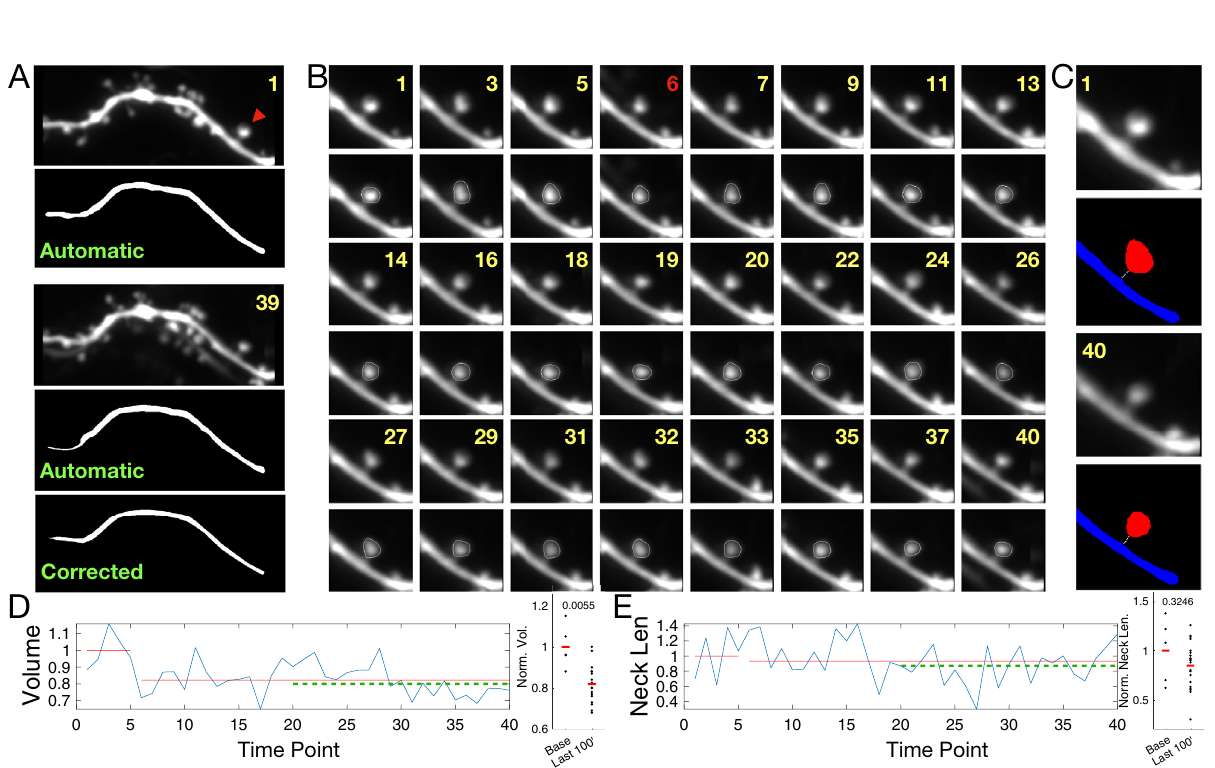
Figure 7. Analysis of glutamate uncaging induced single spine LTD experiment. ( A ) The dendritic segment before (upper panel) and after (lower panel) stimulation. At the first time point, the dendrite segmentation is perfect but at a later time point, fluorescence changes lead to a problematic segmentation which is later corrected by manual interaction. The red arrowhead indicates the stimulated spine. ( B ) Spine head segmentation for 40 consecutive time points. Images were taken once every 5 min. Upper rows—unsegmented image; lower rows—segmented image. Stimulation was performed at the 6th time point. ( C ) Spine before (upper panel) and after (lower panel) undergoing LTD. Median filtered images are above, and segmented images with neck paths are below (Blue: dendrite, Red: spine head, White: spine neck). ( D ) Normalized volume and spine neck results (blue: normalized trends, Red: linear fits for before and after stimulation. Green: average of last 20 time